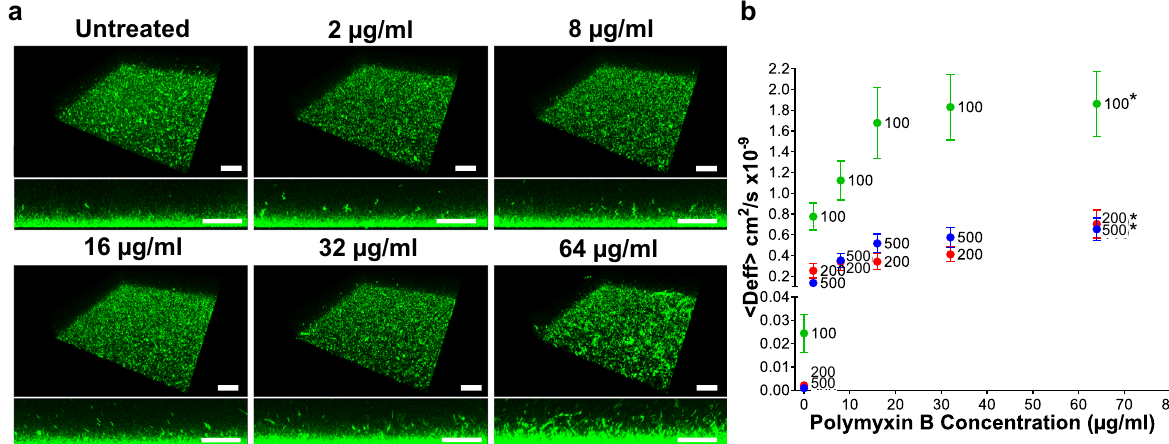
Fig. 3 Nanoparticle diffusion within and disruption of E. coli IR57 (PMB Sens ) bio fi lms treated with Polymyxin B. Polymyxin B (PMB)-treated (2, 8, 16, 32, 64 µg/ml) and untreated PMB Sens E. coli IR57 bio fi lms showing: a CLSM 3D and side-on imaging of bio fi lms grown for 48 h followed by polymyxin B treatment for a further 24 h at 37 °C, visualized using Syto9 ® staining (scale bar, 40 µm; n = 3). b Diffusion coef fi cient <Deff> of 100, 200 and 500 nm negatively charged carboxylate-modi fi ed Fluo Sphere ® particles in non-treated versus polymyxin B treated bio fi lms ( n = 3, ± SEM). *indicates Fluo Sphere ® particle sizes of 100, 200 and 500 nm.